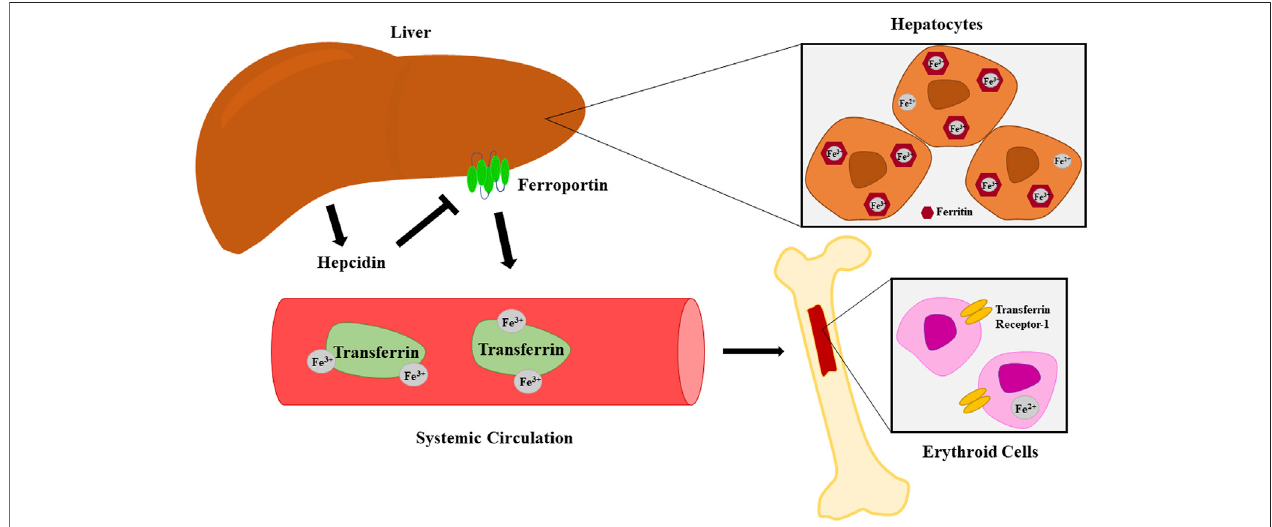
FIGURE 2 | Iron metabolism and transport from hepatocytes to erythroid cells. Hepcidin induces internalization and degradation of the iron-transport protein